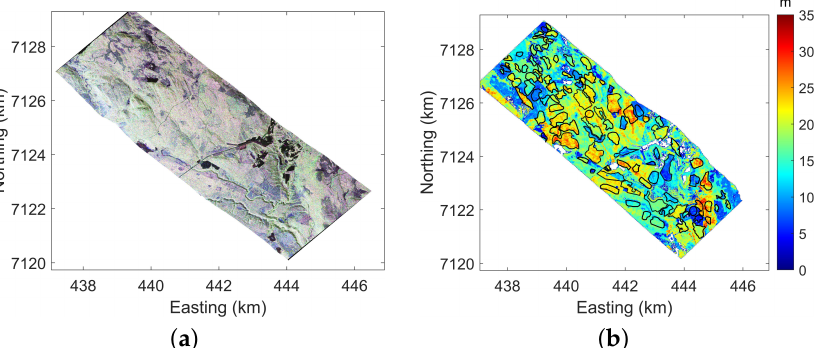
Figure 8. The Pauli-basis color composite map and LiDAR H100 height map. Both maps are defined in the UTM Zone 34 coordinate. ( a ) The Pauli-basis color composite map. ( b ) The LiDAR H100 height map. The polygons are used in the forest height validation. The color ramp ranges from 0 to 35